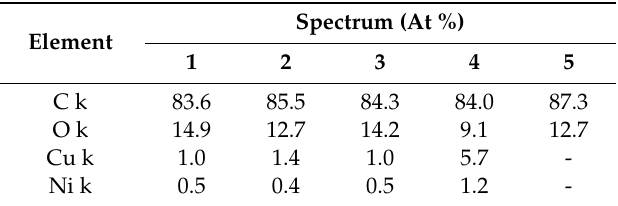
Table 1. Atomic contents (in %) of the elements detected by EDS on the surface of a CuNi NW-loaded substrate.